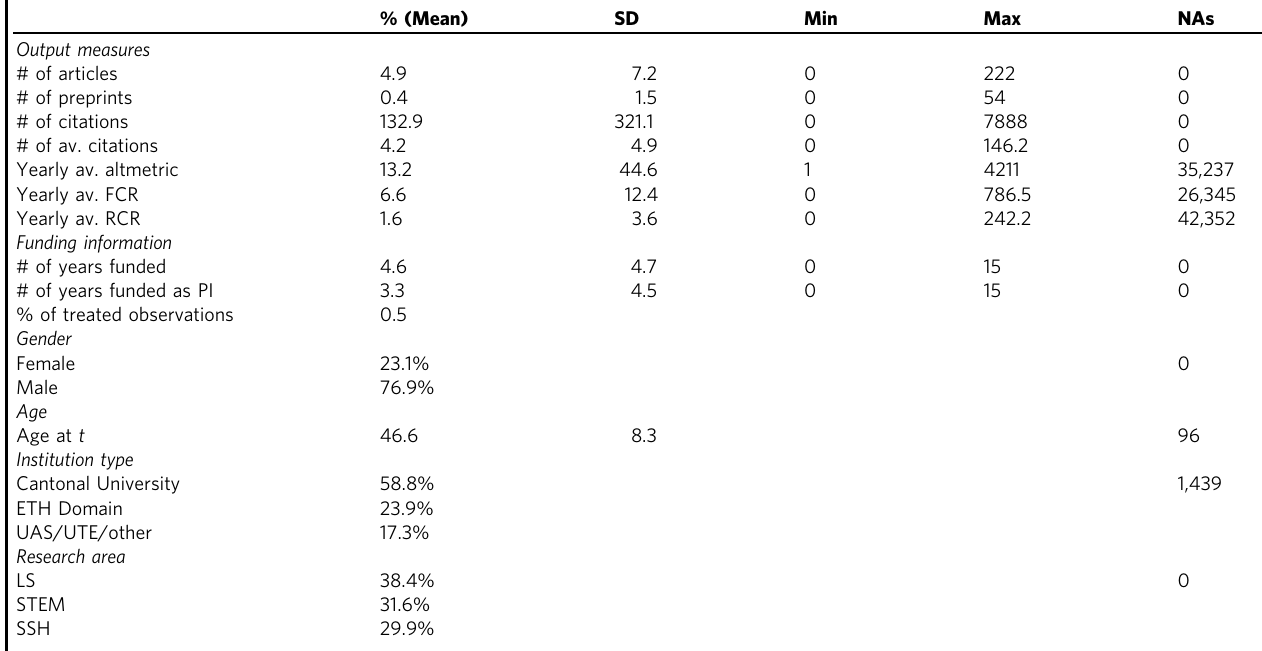
Table 1 Descriptive statistics for the output measures, funding measures and researcher